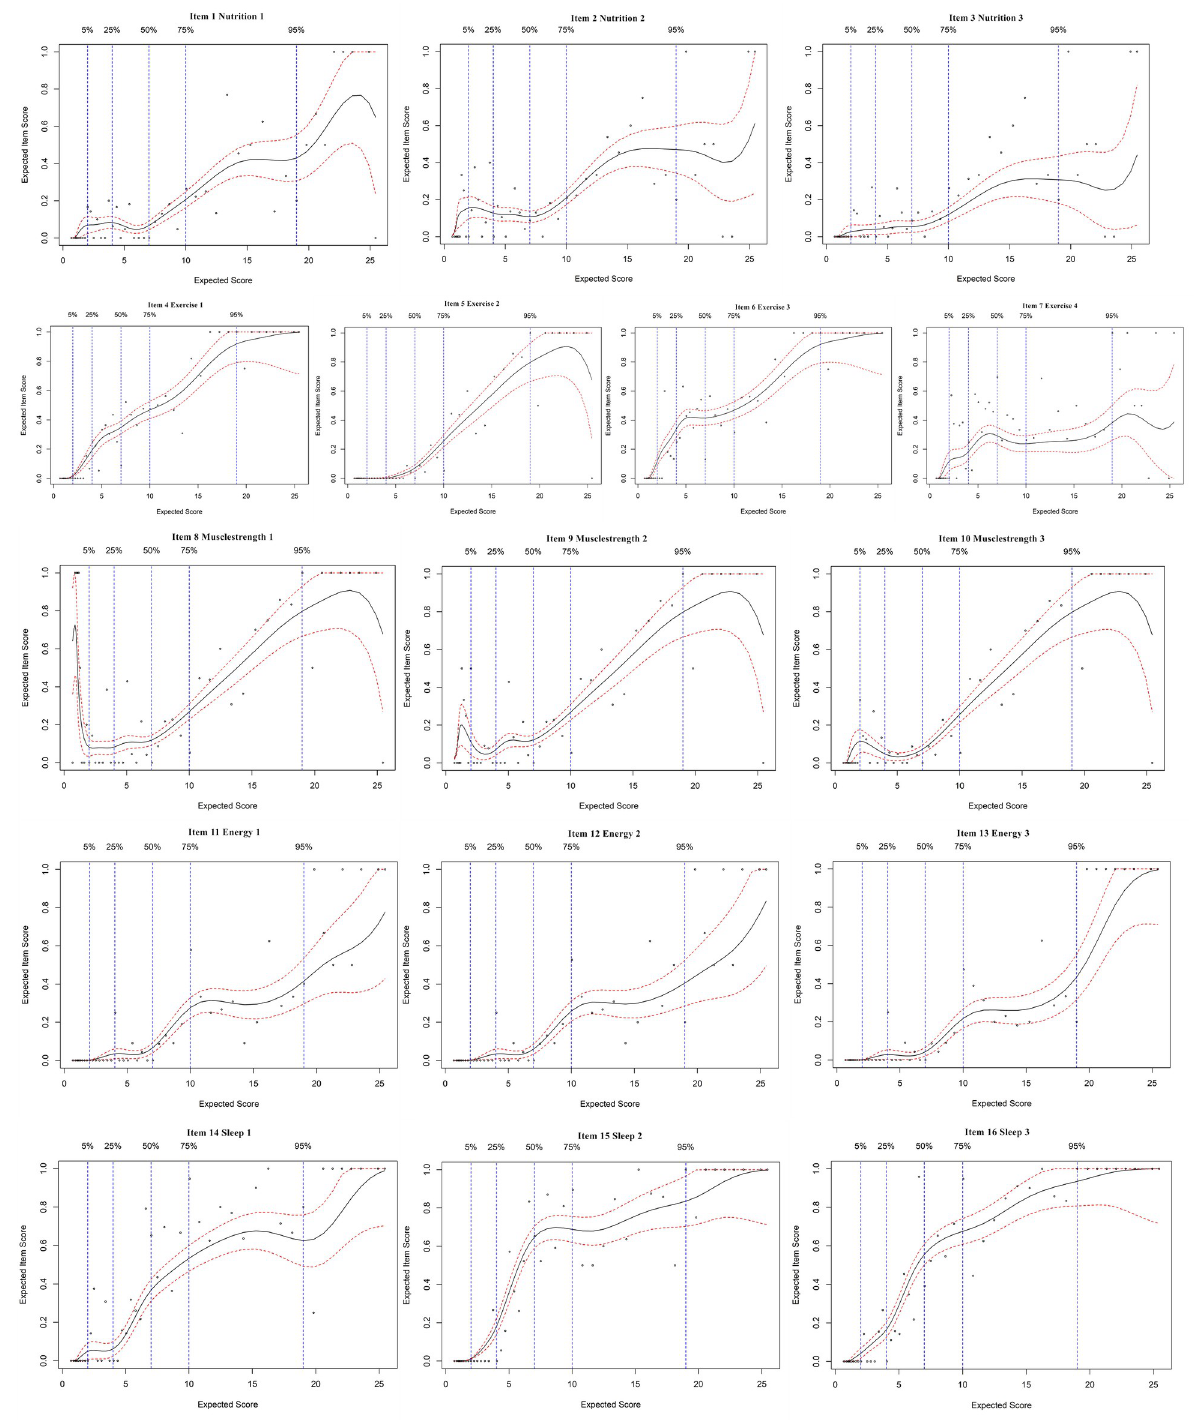
Fig 2. Expected item score curves for physical